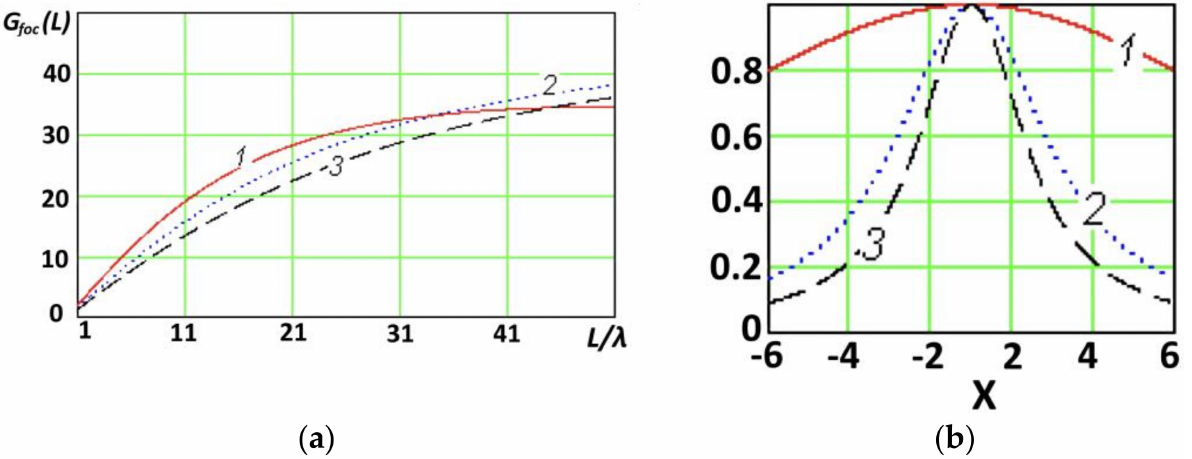
Figure 8. Influence of the types of amplitude distribution on G foc for a focused antenna with focusing point depth z 0 = 7.5 λ : dependence of G foc on the electrical length of the antenna ( a ) and on the type of amplitude distribution ( b